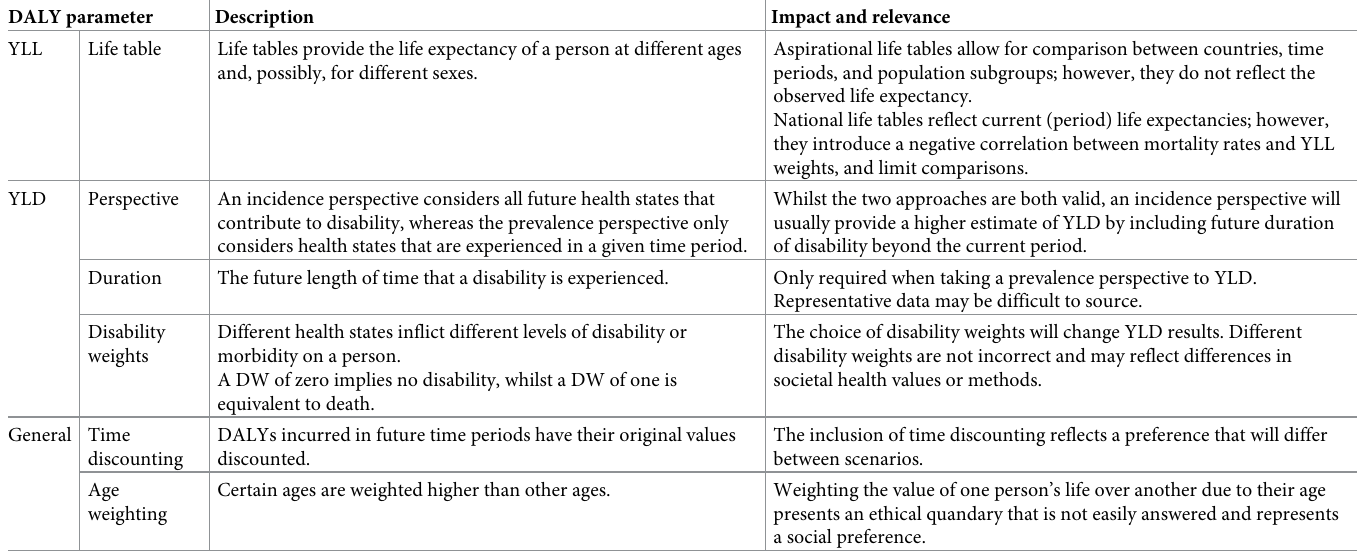
Table 1. Basic DALY